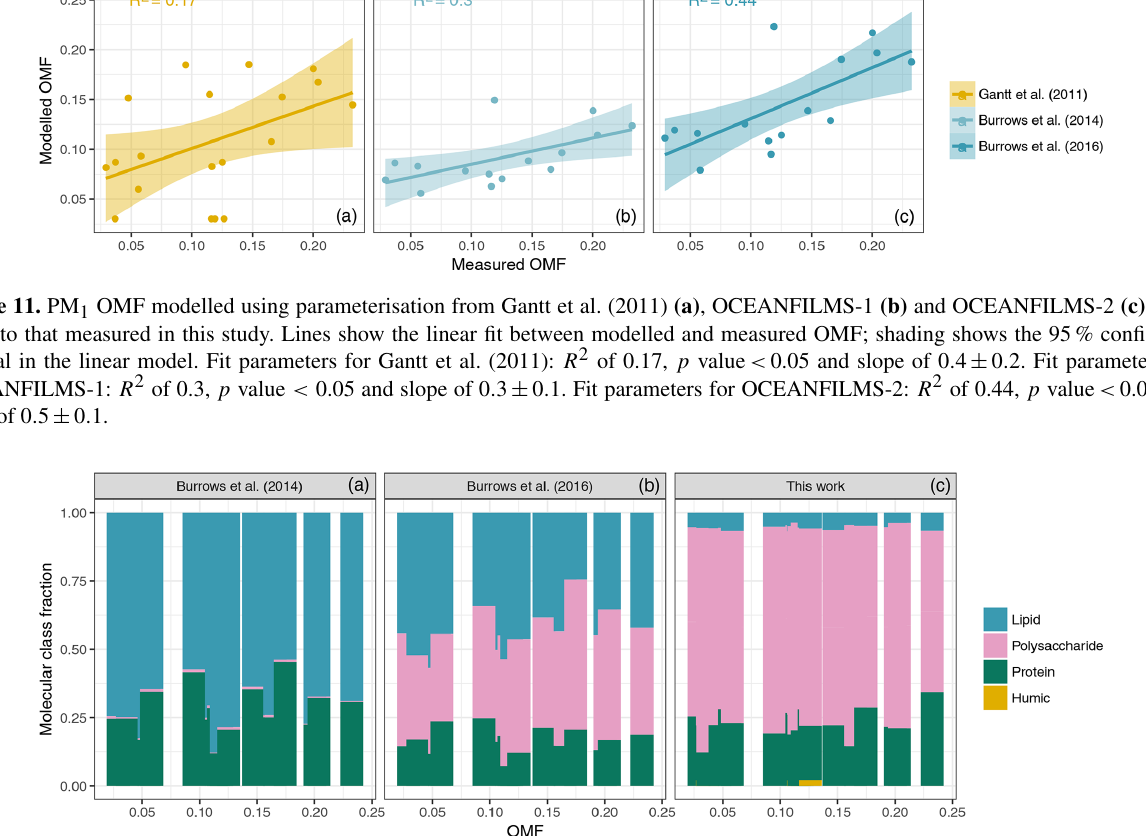
Figure 12. Measured organic composition inferred from functional groups (c) and modelled organic composition from OCEANFILMS (OCEANFILMS-1, a ; OCEANFILMS-2, b